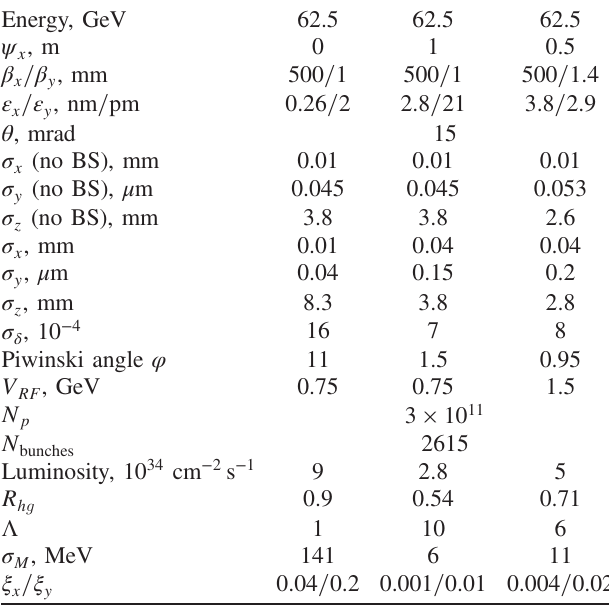
FIG. 5. Hour-glass reduction factor.